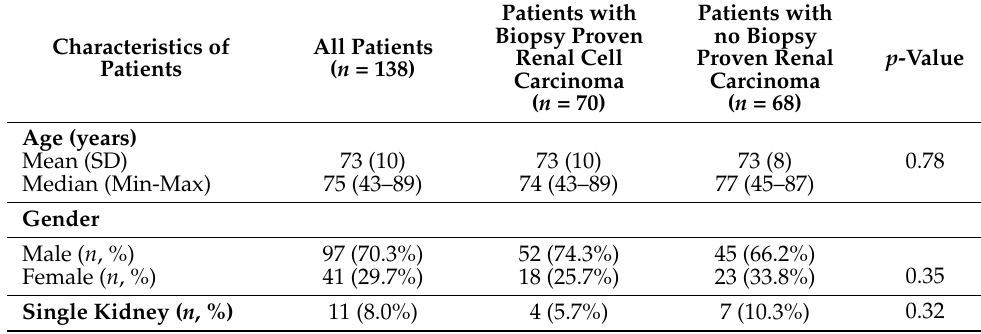
Table 1. Characteristics of included patients.